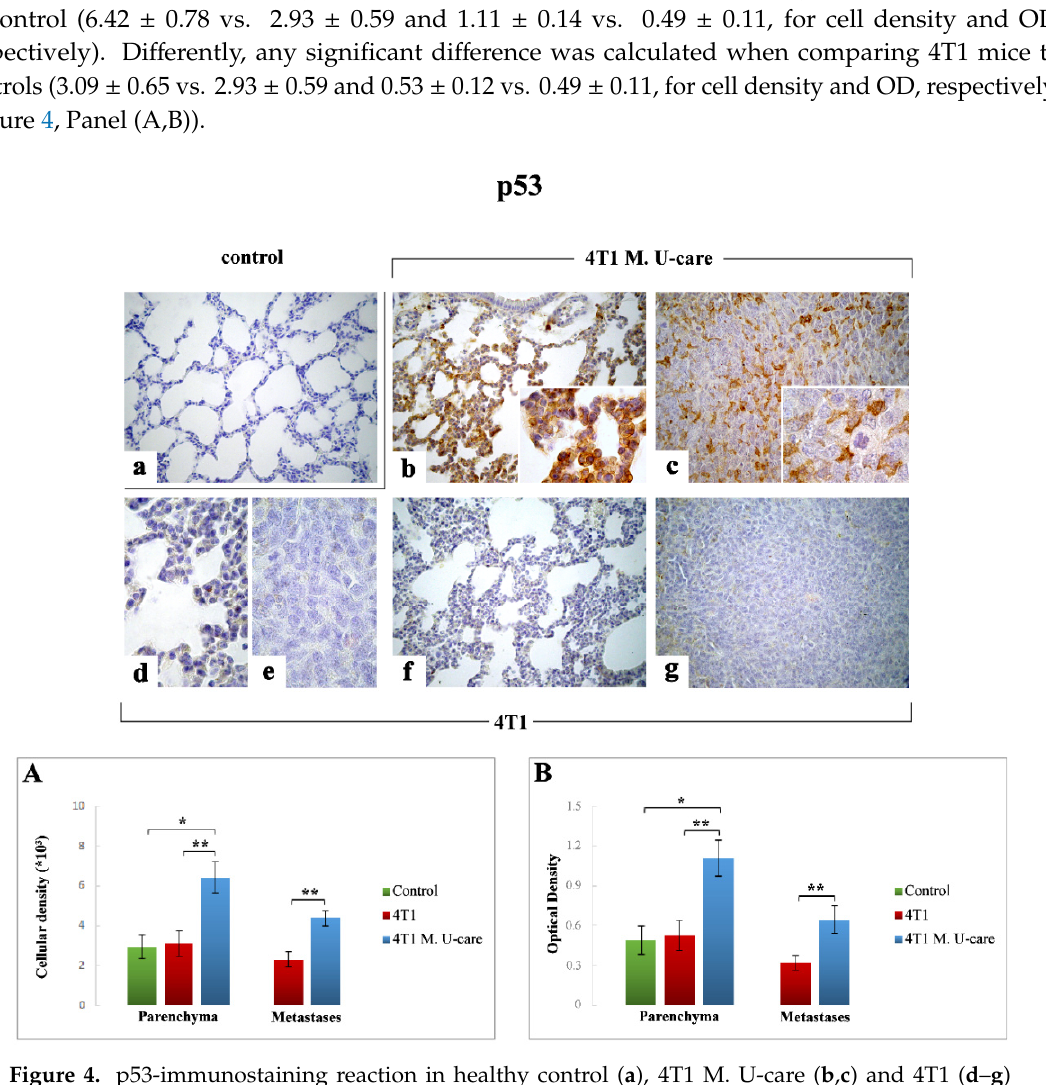
Figure 4. p53-immunostaining reaction in healthy control ( a ), 4T1 M. U-care ( b , c ) and 4T1 ( d – g ) mice.